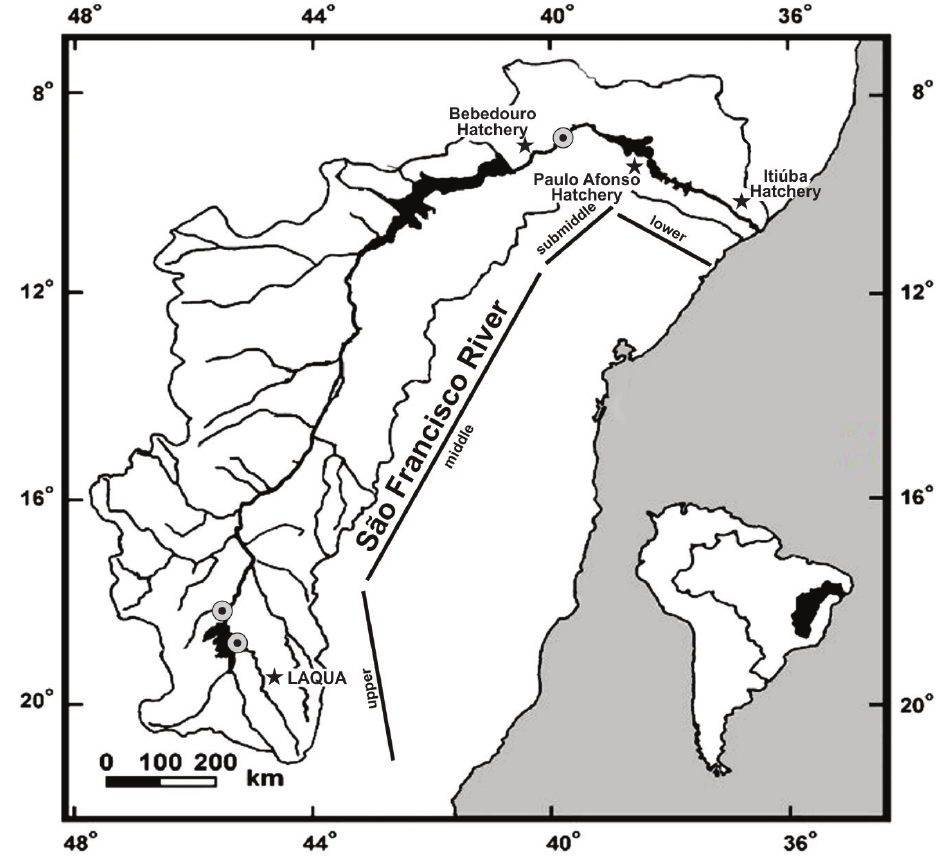
upper and submiddle stretches are denoted by